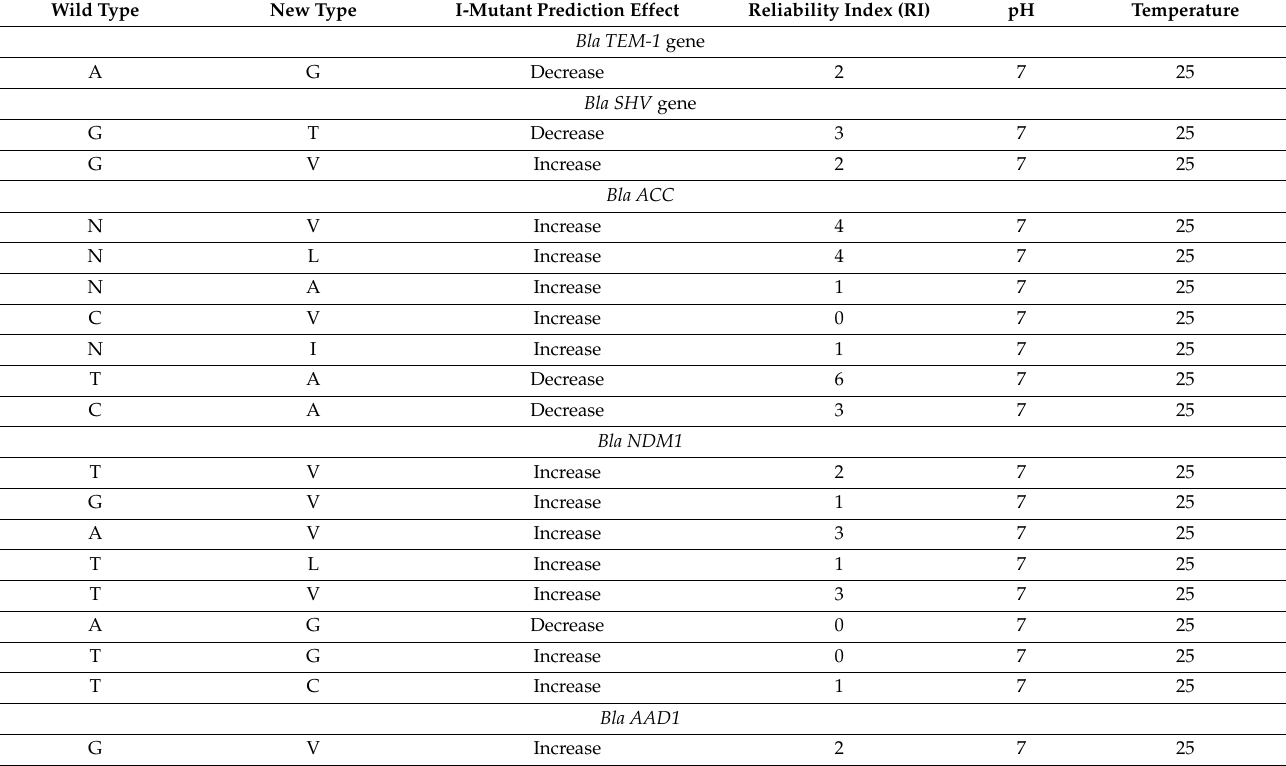
Table 8. The I-Mutant software prediction result for selected antibiotic-resistant